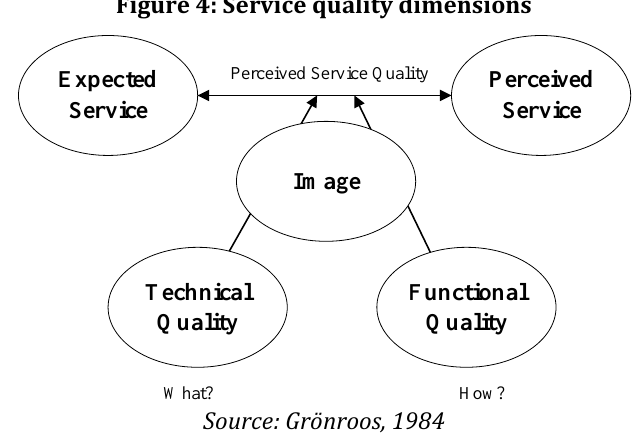
Figure 4: Service quality